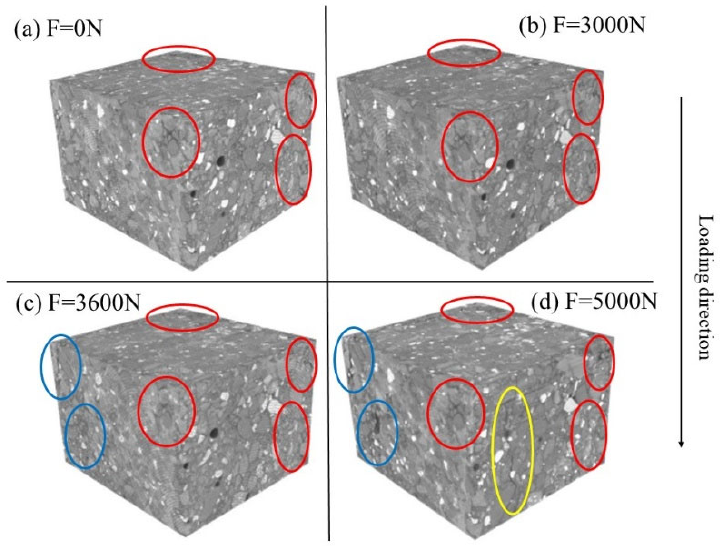
Figure 5. Three-dimensional crack distributions under di ff erent